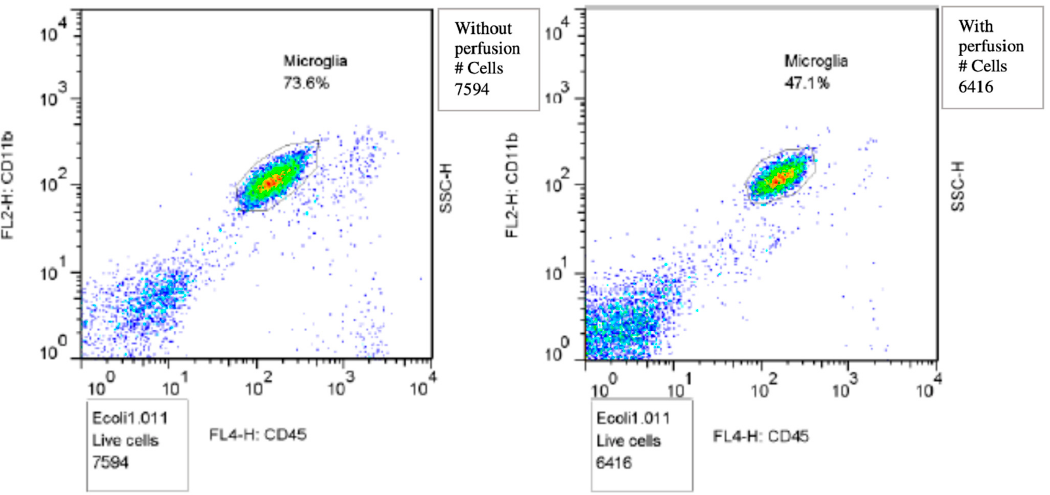
Cells 2021 , 10 , x FOR PEER REVIEW Figure A2. Test samples for flowcytometric analysis without and with cerebral perfusion with PBS.